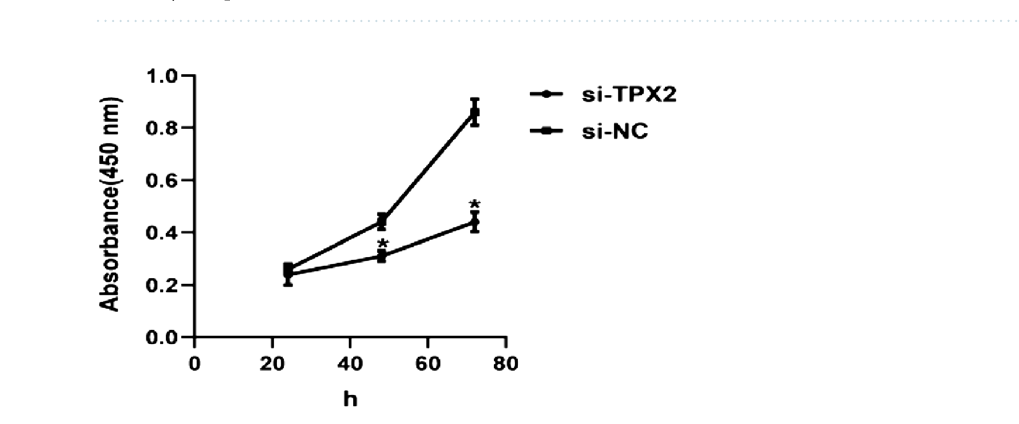
Figure 11. ( a, b ) Western blot method to detect TPX2 protein expression in normal alveolar epithelial cells BEAS-2B and non-small cell lung cancer cells A549. ( c, d ) Western blot method to detect si-TPX2 transfection efficiency. ‘*’represents P < 0.05.